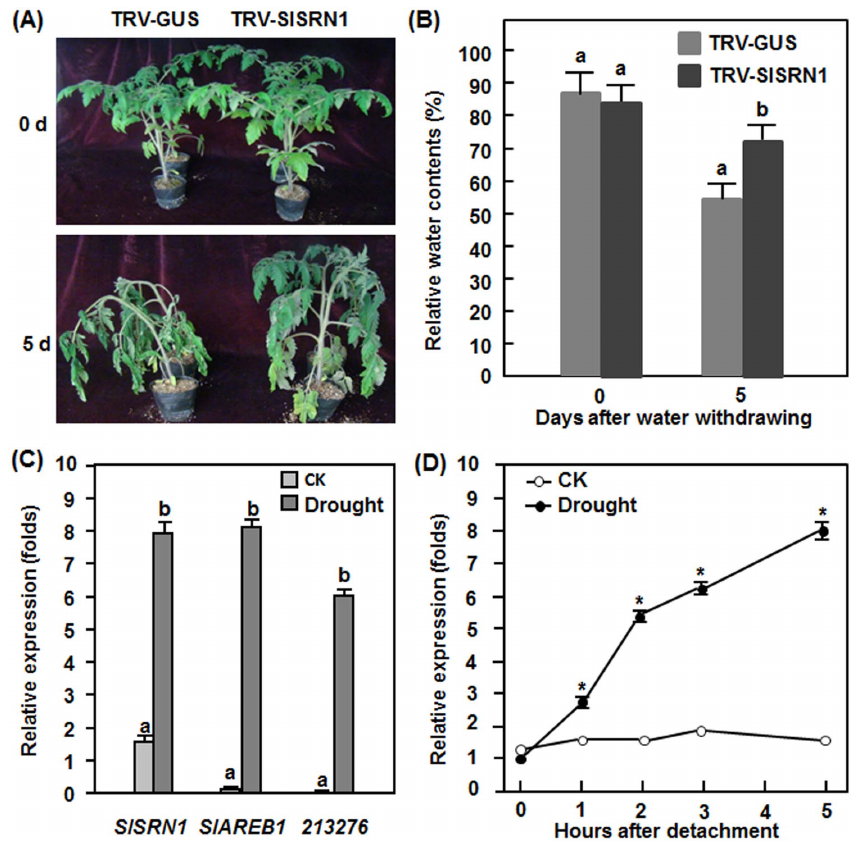
Figure 8. Silencing of SlSRN1 increased tolerance to drought stress. (A) and (B), Phenotype (A) and relative water contents (B) in leaves from the TRV-SlSRN1- or TRV-GUS-infiltrated plants at 5 days after drought treatment. Two-week-old seedlings were infiltrated with agrobacteria carrying TRV-SlSRN1 or TRV-GUS and allowed for further growth for another 2 weeks. The TRV-SlSRN1- or TRV-GUS-infiltrated plants were treated for drought stress by stopping watering for a period until wilting symptom was appeared. (C) and (D), Expression of SlSRN1 induced by drought stress. Four- week-old tomato plants were treated for drought stress by stopping watering for a period or watered normally as controls and leaf samples were collected at 7 days after treatment when wilting symptom appeared (C). Fully expanded leaves were detached from four-week-old plants and subjected to drought stress treatment by placing on lab blench or water-saturated filter papers in Petri dishes as a control and samples were collected at different time points as indicated. Total RNA was extracted and used for qRT-PCR analysis. Data presented in (B), (C) and (D) are the means 6 SD from three independent experiments and different letters above the columns and the asteriks above the lines indicate significant differences at p , 0.05